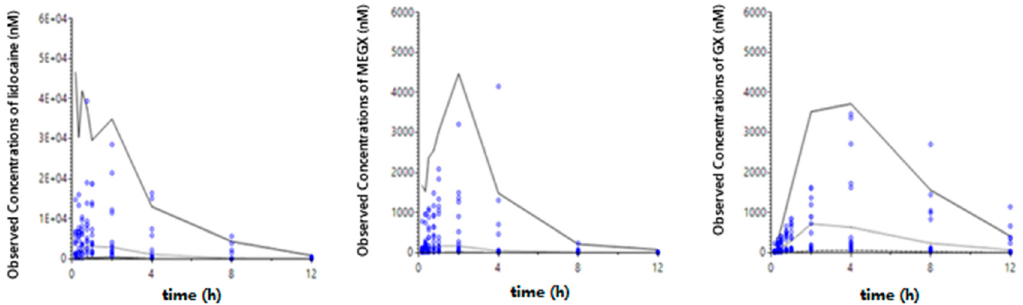
Figure 6. Visual predictive check plot of the final model. A total of 1000 datasets were simulated using the final PK parameter estimates. Circles represent the observed lidocaine, MEGX, and GX concentrations. The lines in each graph represent 5th, median, and 95th percentiles of the simulated concentrations.